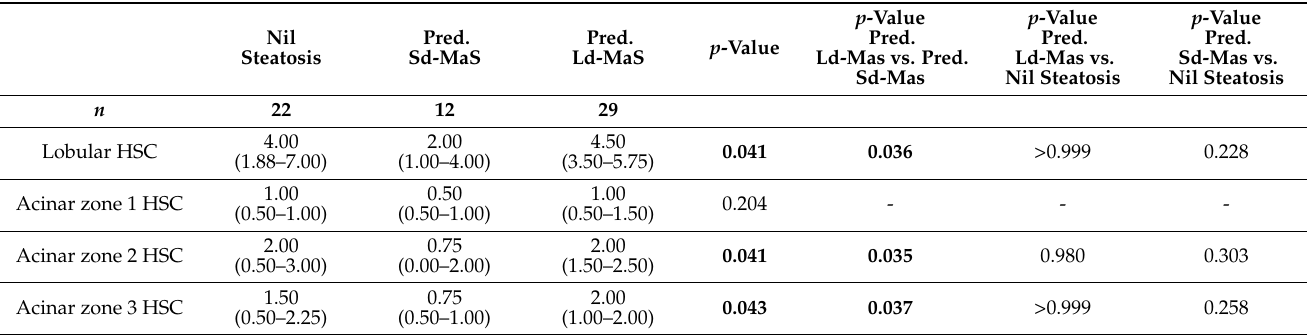
Table 2. Liver graft HSC total and zonal activation according to the presence and the predominant type of steatosis.